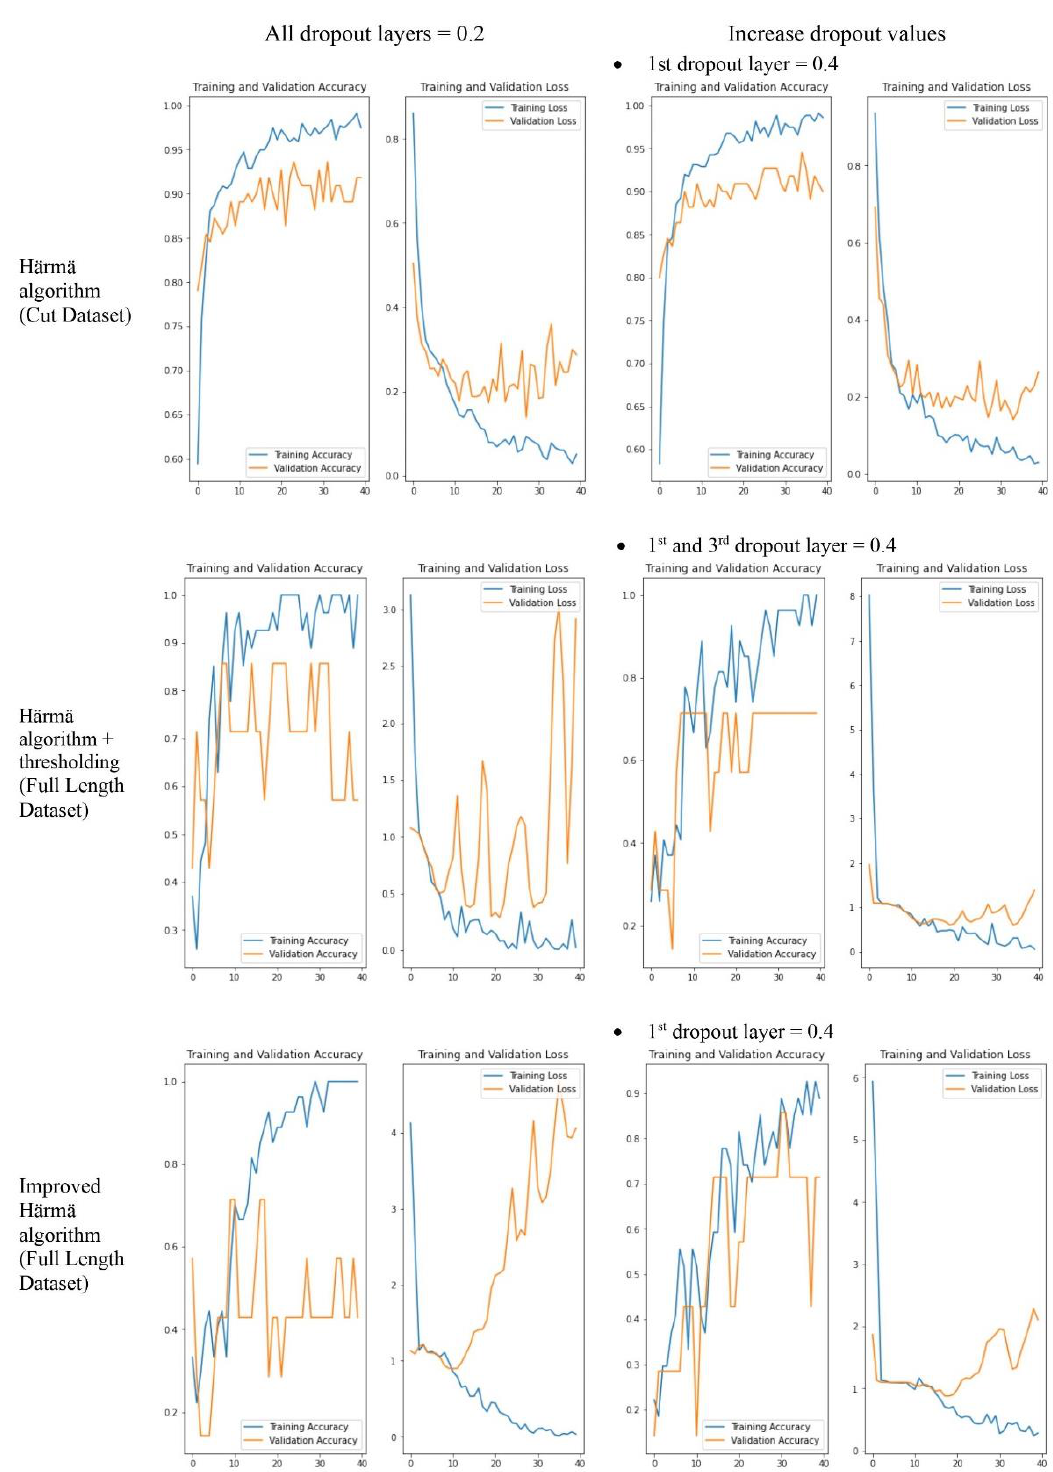
Figure 12. Samples of Training and Validation Accuracy and Loss Graph.